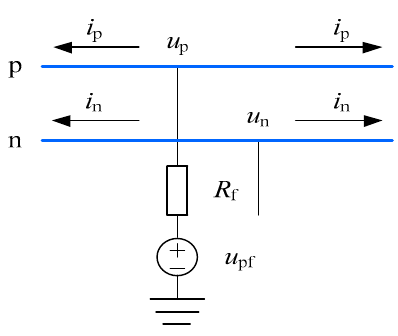
Figure 12. Positive pole-to-ground fault.